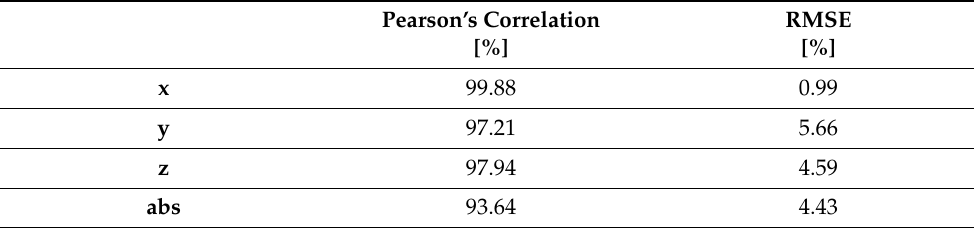
Table 3. Pearson’s correlation and RMSE computed for real and simulated acceleration